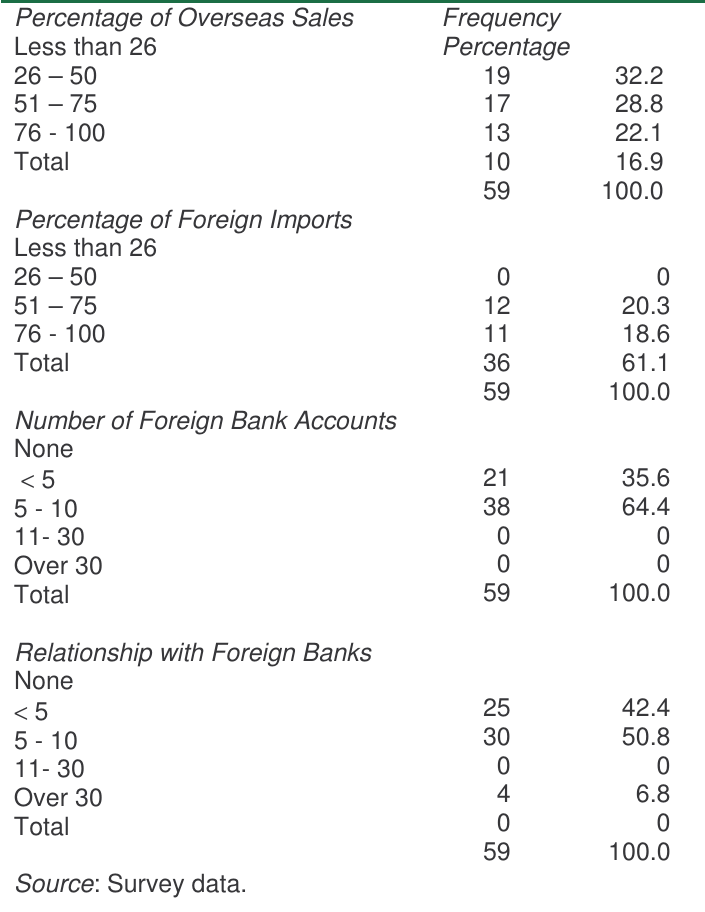
Table 2: International Trade